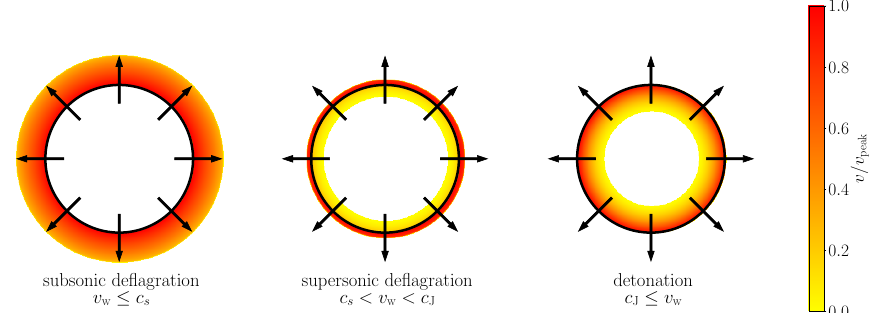
Figure 14: Sketch of the three different cases of relativistic combustion. A subsonic deflagration (left) occurs detonation when the fluid is at rest inside the bubble and the wall moves at subsonic speed. The opposite case is a detonation (right) where the fluid outside the bubble is at rest and the wall moves at supersonic speed. In the hybrid case (mid) the wall speed is supersonic and the fluid is moving both ahead and behind the wall. Credit: D. Cutting.